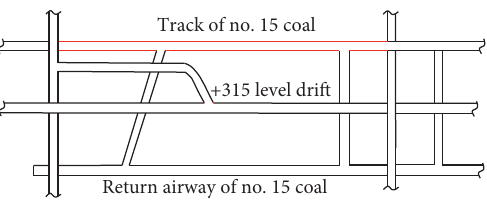
Figure 16: Roadway layout of face No. 603.